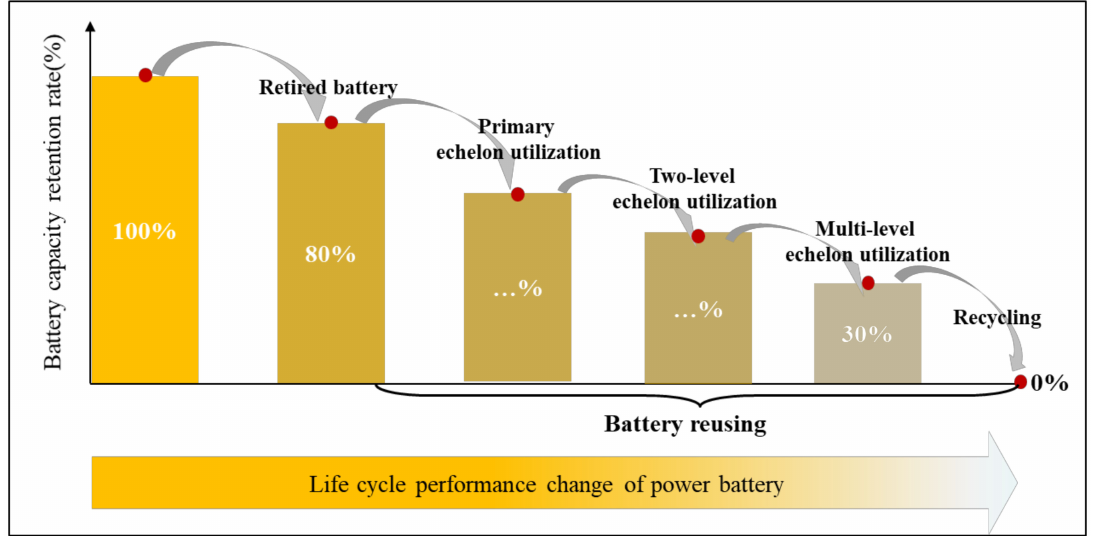
Figure 4. Main ways of power battery reusing of